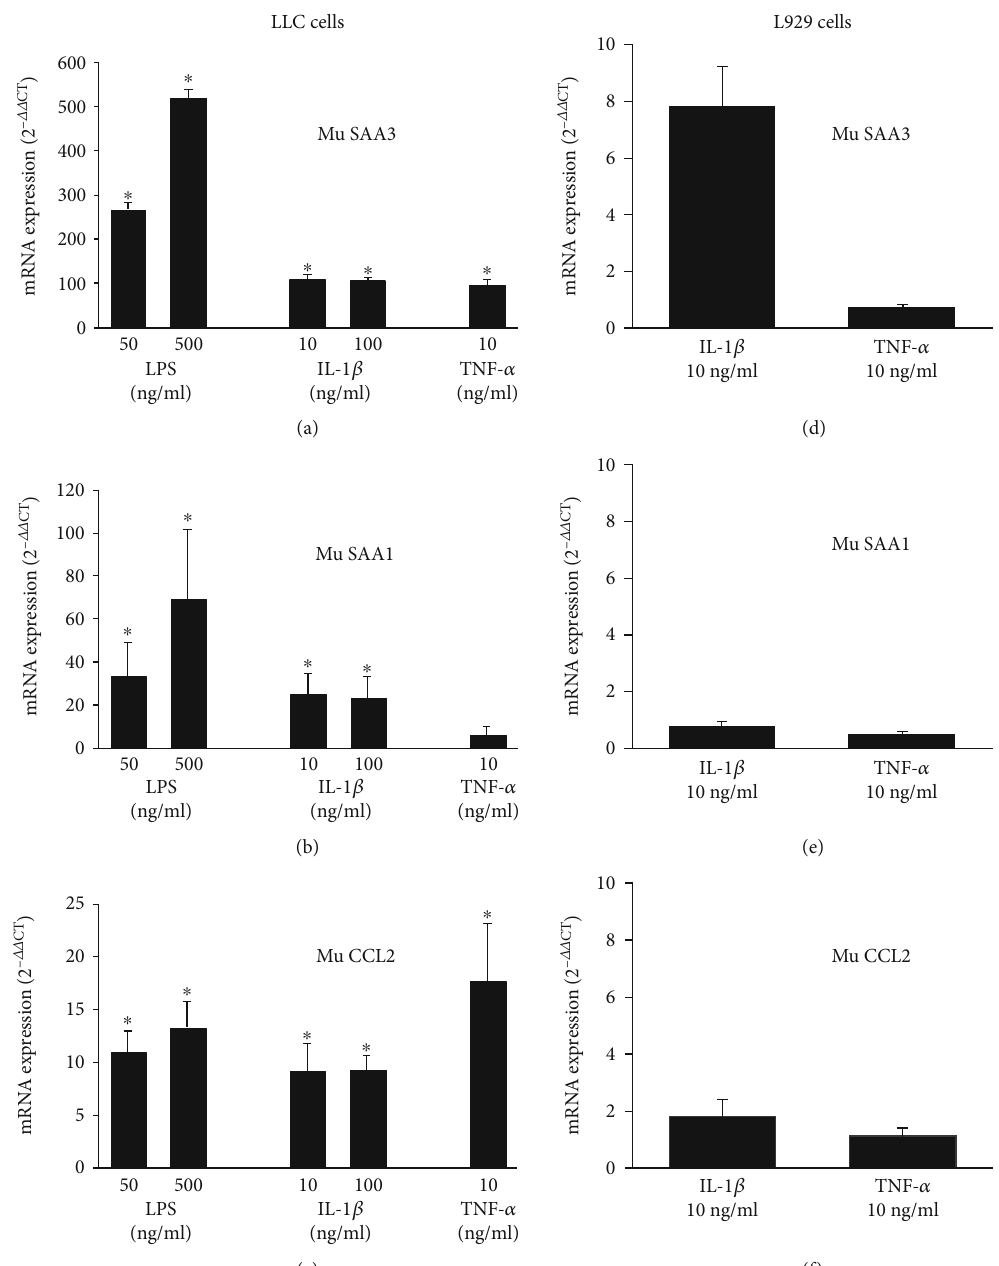
Figure 1: In fl ammatory mediators stimulate the expression of mu SAA1, SAA3 and CCL2 mRNA in murine Lewis lung carcinoma cells (LLC cells) and the expression of SAA3 mRNA in murine L929 fi broblasts. LLC cells (a – c) or L929 cells (d – f) were stimulated with LPS (50 or 500ng/ml; a – c), IL-1 β (10 ng/ml; a – f), IL-1 β (100ng/ml; a – c), TNF- α (10 ng/ml; a – f) or were left untreated. After 16 h, total cell RNA was extracted and single-stranded cDNA was produced. Expression of mu SAA3 (a and d), mu SAA1 (b and e) and mu CCL2 (c and f) mRNA was detected via real-time polymerase chain reaction (RT-PCR) and upregulation of the expression was determined using the 2 − ΔΔ Ct method. Data represent the mean foldmRNAchange ± SEM in stimulated cells compared to untreated cells and are derived from 3 (a – c) or 2-8 (d – f) independent experiments. Statistically signi fi cant upregulation of mRNA compared to control cells, determined by the Mann-Whitney U test, is indicated by asterisks ( ∗ p < 0 : 05